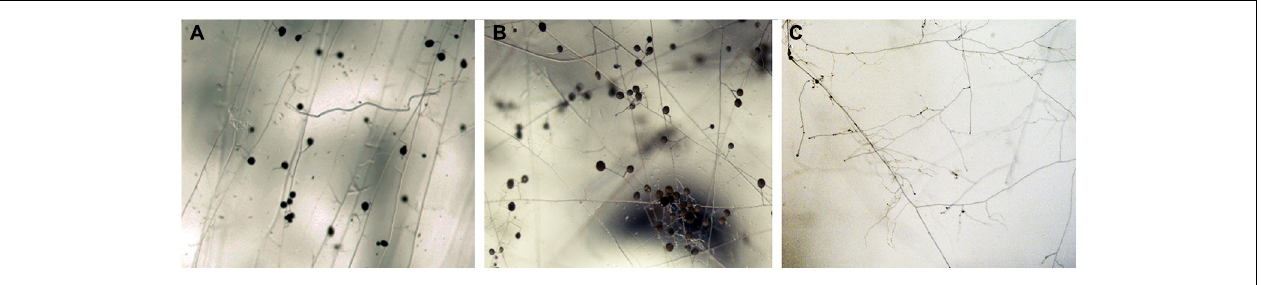
FIGURE 1 | Effect of Cu on extraradical hyphal development of Rhizophagus irregularis grown in vitro in association with root organ cultures. Extraradical mycelium (ERM) was grown in minimal medium lacking